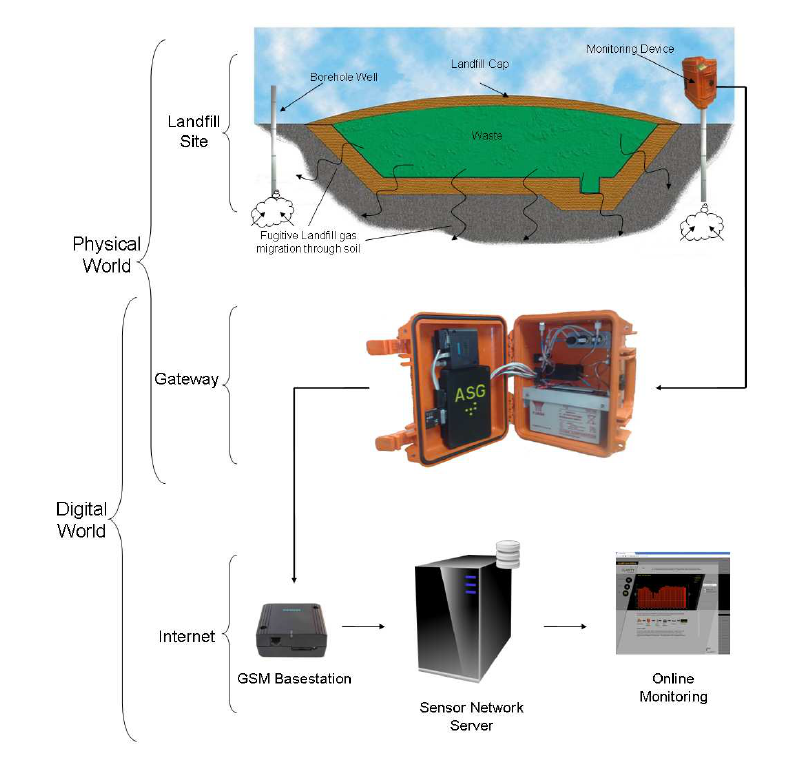
Figure 1. Visual representation of the landfill gas sensing model from the device placed in the field to a web-based visualisation user interface. The model shows the progression of chemical sensed data from the physical world to the digital world by means of a gateway